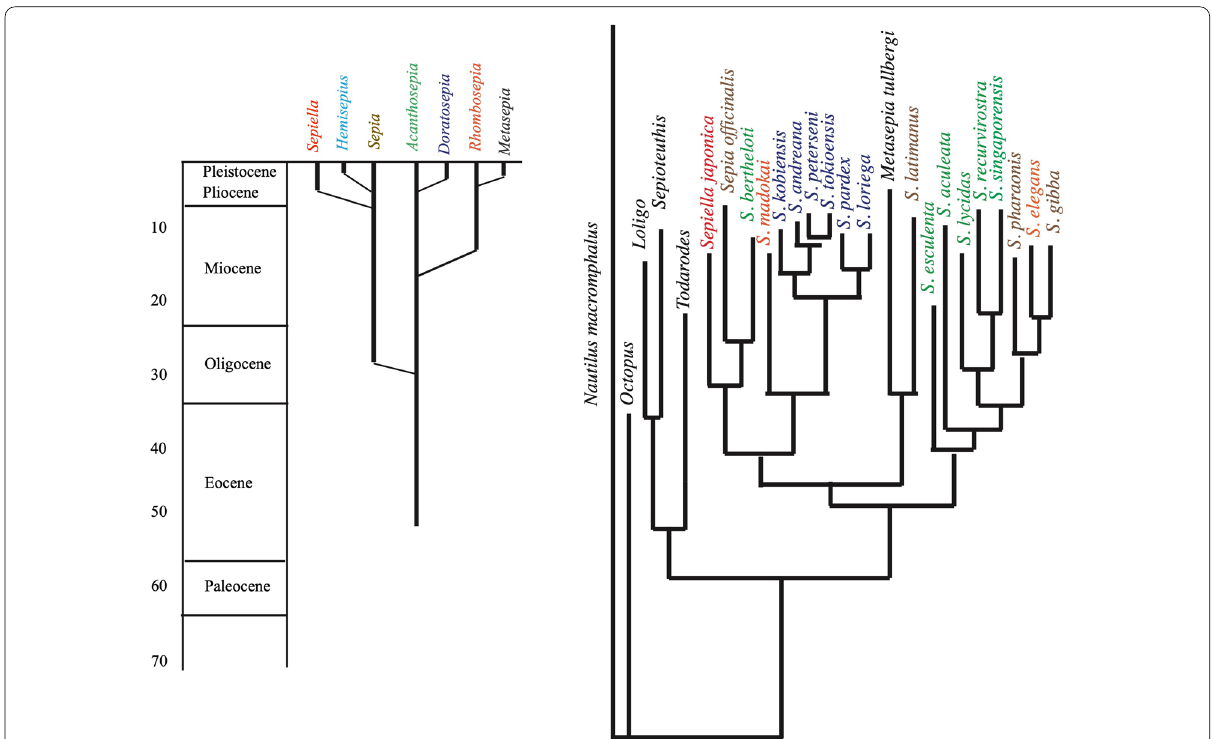
Fig. 5 Khromov—phylogeny (modified after Yoshida et al. 2006). On left, geological ranges of the various Khromov defined subgenera. On right, DNA based phylogeny of sepiids, falsifying the Khromov “subgenera” as actual